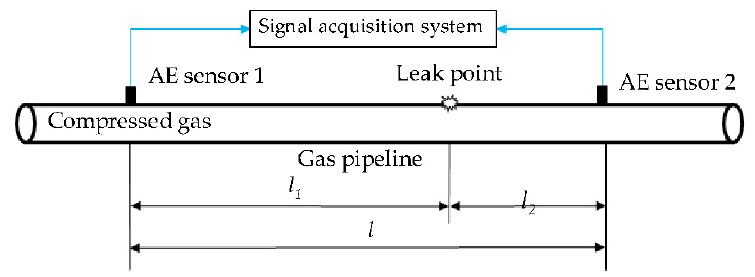
Figure 1. Schematic of the pressurized piping system.